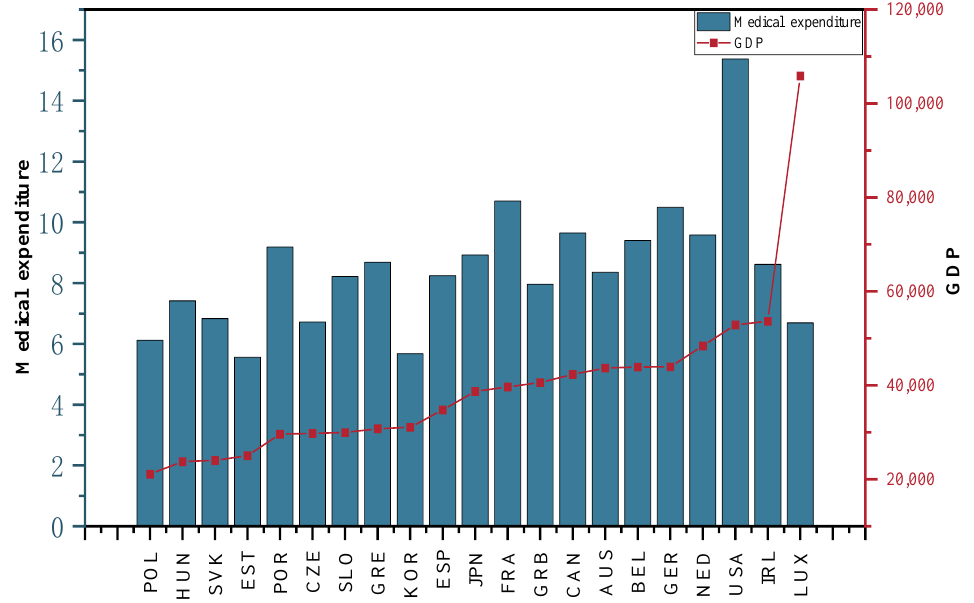
Figure 11. Average GDP per capita and medical expenditure in the selected OECD countries, 2001–2015. Gross domestic product (GDP) per capita for the selected OECD countries from 2001 to 2015 is used to represent the level of economic development of the respective